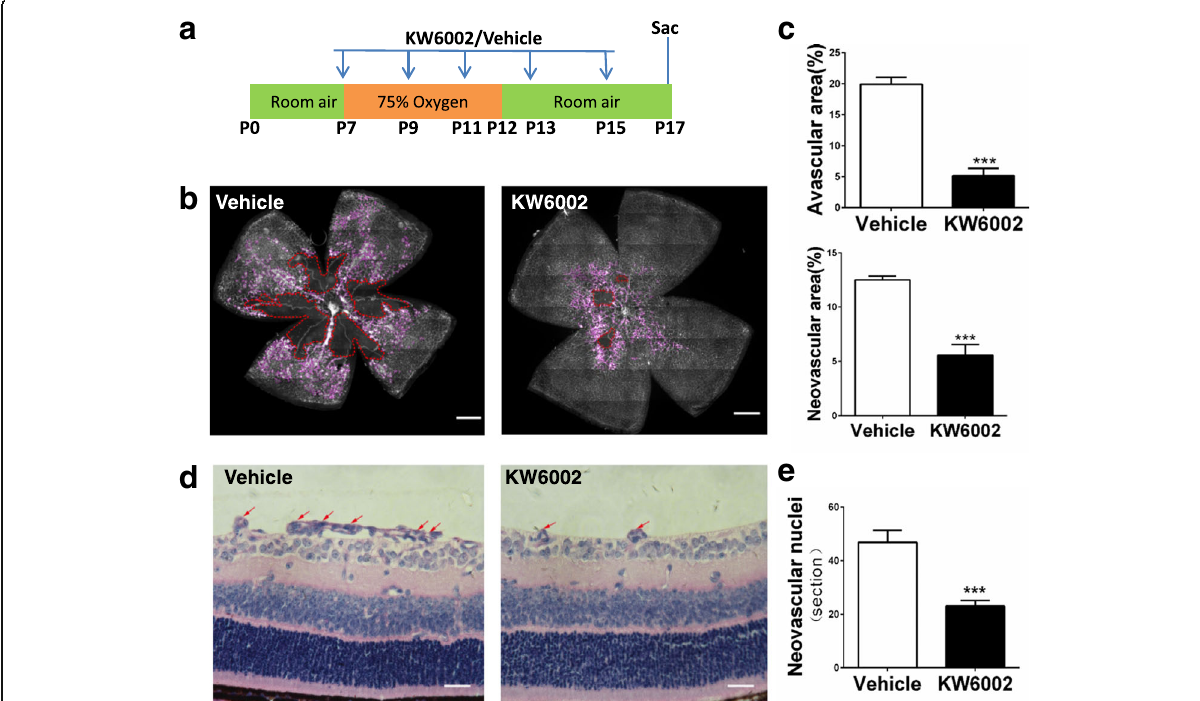
Fig. 2 KW6002 treatment attenuated retinal avascular area and pathological angiogenesis at P17 in OIR. a Schematic of the experimental design: KW6002 was administered by intraperitoneal injection at volume of 10 mg/kg from P7 to P15 every other day. OIR mice were euthanized at P17. b Following the OIR, retinal vasculatures from KW6002- and vehicle-treated mice were visualized by whole-mount isolectin B4 at P17. Avascular areas are indicated by red dotted line. Neovascularization tufts are indicated by purple line. Scale bar: 500 μ m. c Quantitative analysis of avascular areas by isolectin B4 and the neovascular tufts area showed that KW6002 treatment reduced avascular areas(Student ’ s t-test) and neovascular tufts area(Mann-Whitney U test)compared to the vehicle-treated pups. *** P < 0.001, n = 11 – 13/group. d Representative H-E staining images showing the neovascular nuclei numbers (red arrow) on the vitreal side of the inner limiting membrane. Scale bar: 20 μ m. e Quantitative histochemical analysis showed that KW6002 treatment (P7 – 17) reduced neovascular nuclei numbers as compared to the vehicle-treated pups. *** P < 0.001, Student ’ s t-test, n = 11 – 13